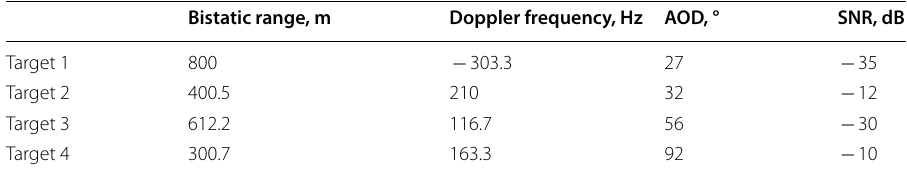
Table 4 Predicted SNR Matched filter of Beam 1 Matched filter of Beam 2 Matched